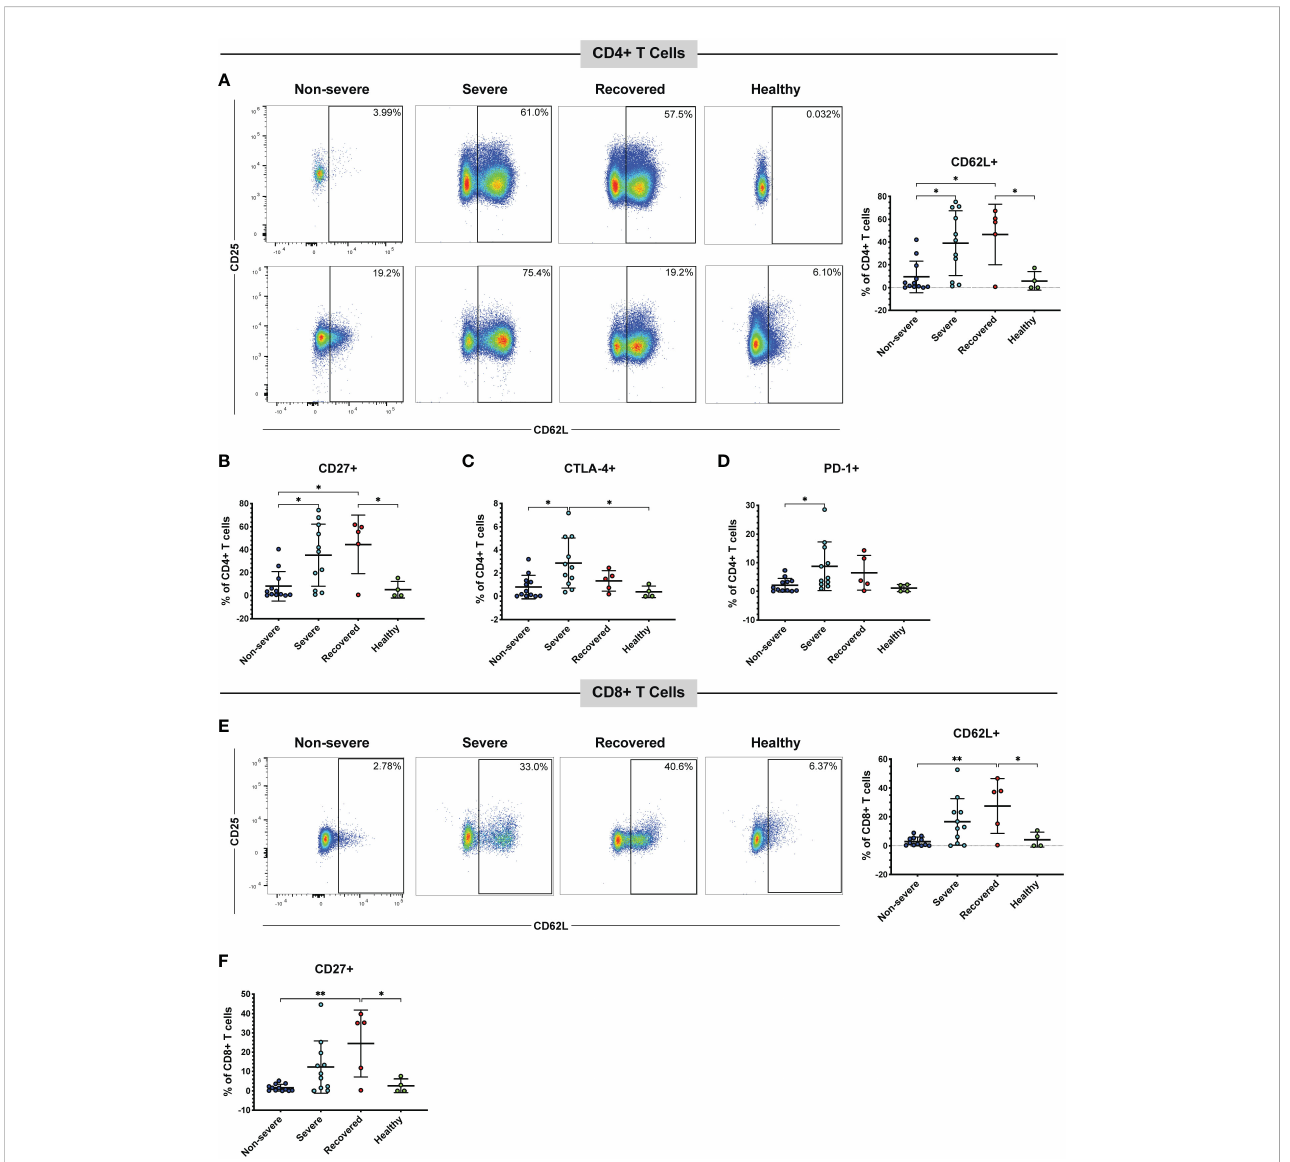
FIGURE 1 Severe and recovered COVID-19 patients have greater frequencies of CD62L+ T cells. The frequencies of CD4+ and CD8+ T cells (viable, CD14-, CD56- , CD19-, CD3+, CD4+ or CD8+ cells) expressing CD62L in non-severe and severe COVID-19 patients, recovered COVID-19 patients, and healthy controls were assessed by fl ow cytometry. (A) CD62L+ CD4+ T cells and representative fl ow cytometry plots. Each plot represents a different patient; percentages of CD4+ CD62L+ CD27+ cells (B) , CD4+ CD62L+ CTLA-4+ cells (C) , CD4+ CD62L+ PD-1+ cells (D) , CD8+ CD62L+ cells and representative fl ow plots (E) , and CD8+ CD62L+ CD27+ cells (F) within the total CD4+ T cell (A-D) and CD8+ T cell (E, F) populations; *p<0.05, **p<0.01 one-way ANOVA with multiple comparisons correction. Data are graphed as percentages of the total CD4+ or CD8+ T cell